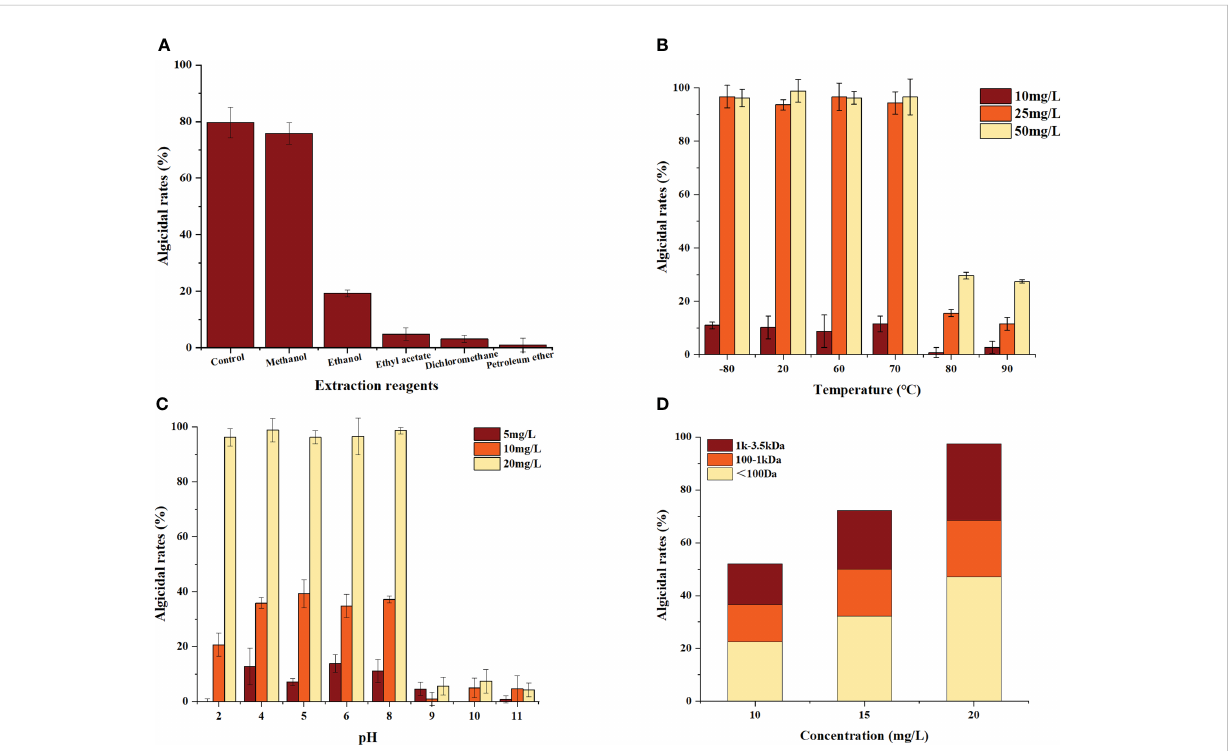
FIGURE 2 Algicidal characteristics of the crude Bacillus spp. extracts. Three replicates were used for error bars (representing the standard deviation). (A) Algal inhibition effects of the extracts produced using different polar extractants. (B) The effect of temperature on the algae inhibition activity of the crude extracts. (C) The effect of pH value on the algae inhibition activity of the crude extracts. (D) Differences in the algae inhibitory activities of the crude extracts with different molecular weight ranges).